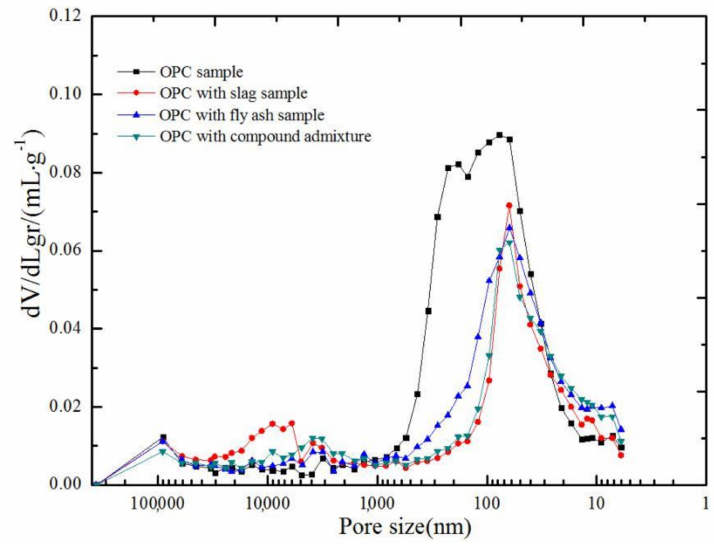
Figure 6. Pore size distribution of cement mortar.